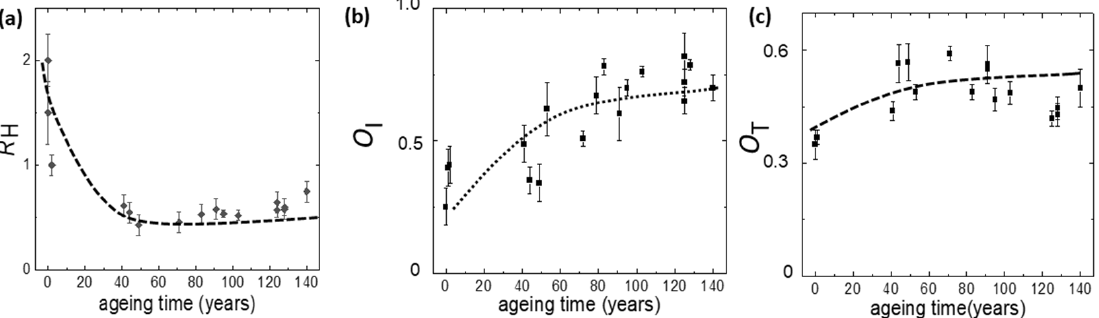
Figure 10. Behavior of the mean values of the ( a ) R H , ( b ) O I, and ( c ) O T markers from Raman spectra of several regions of non-printed areas of books of XIX, XX, and XXI centuries as a function of the ageing time.